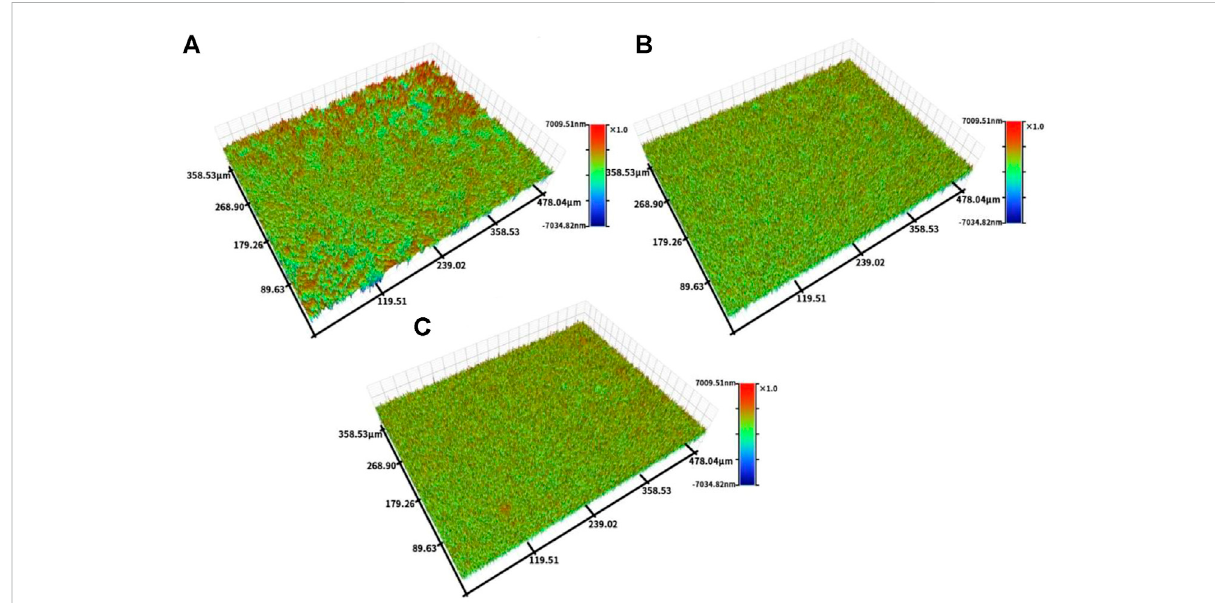
FIGURE 4 Pro fi ler surface topographies for each group of samples, and (A) Ti, (B) TCP and (C) TCP-SA.